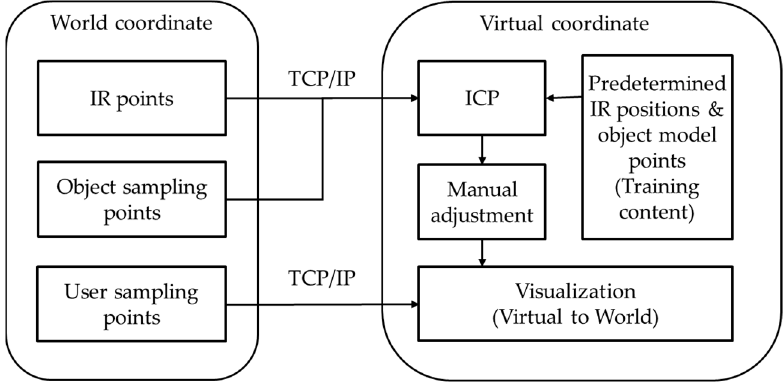
Figure 8. Process of sample points matching between real and virtual objects.